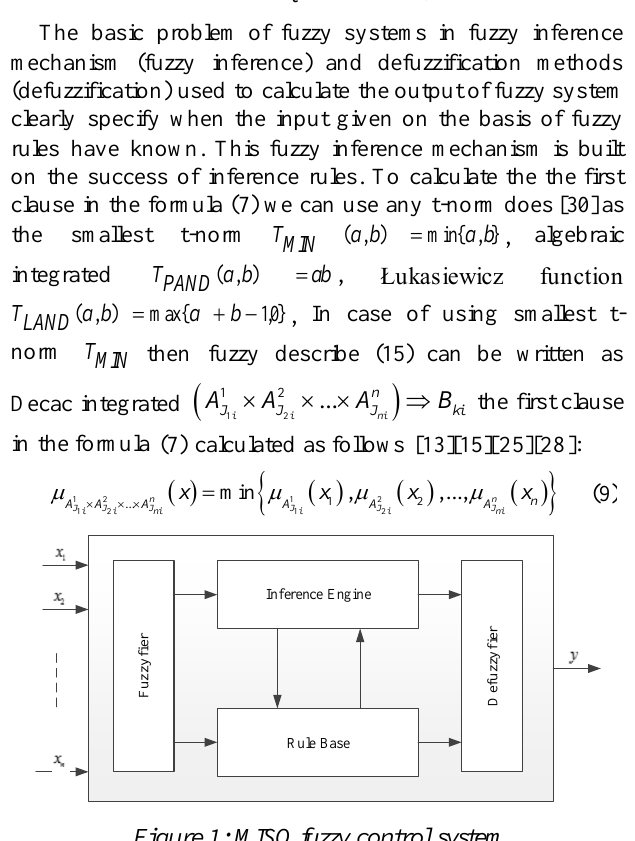
Figure 1: MISO fuzzy control